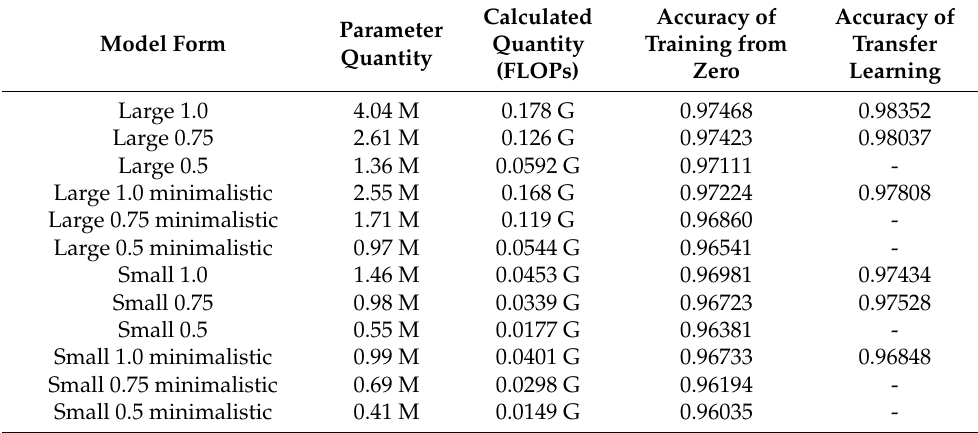
Table 1. Overview of the performance of the transfer learning